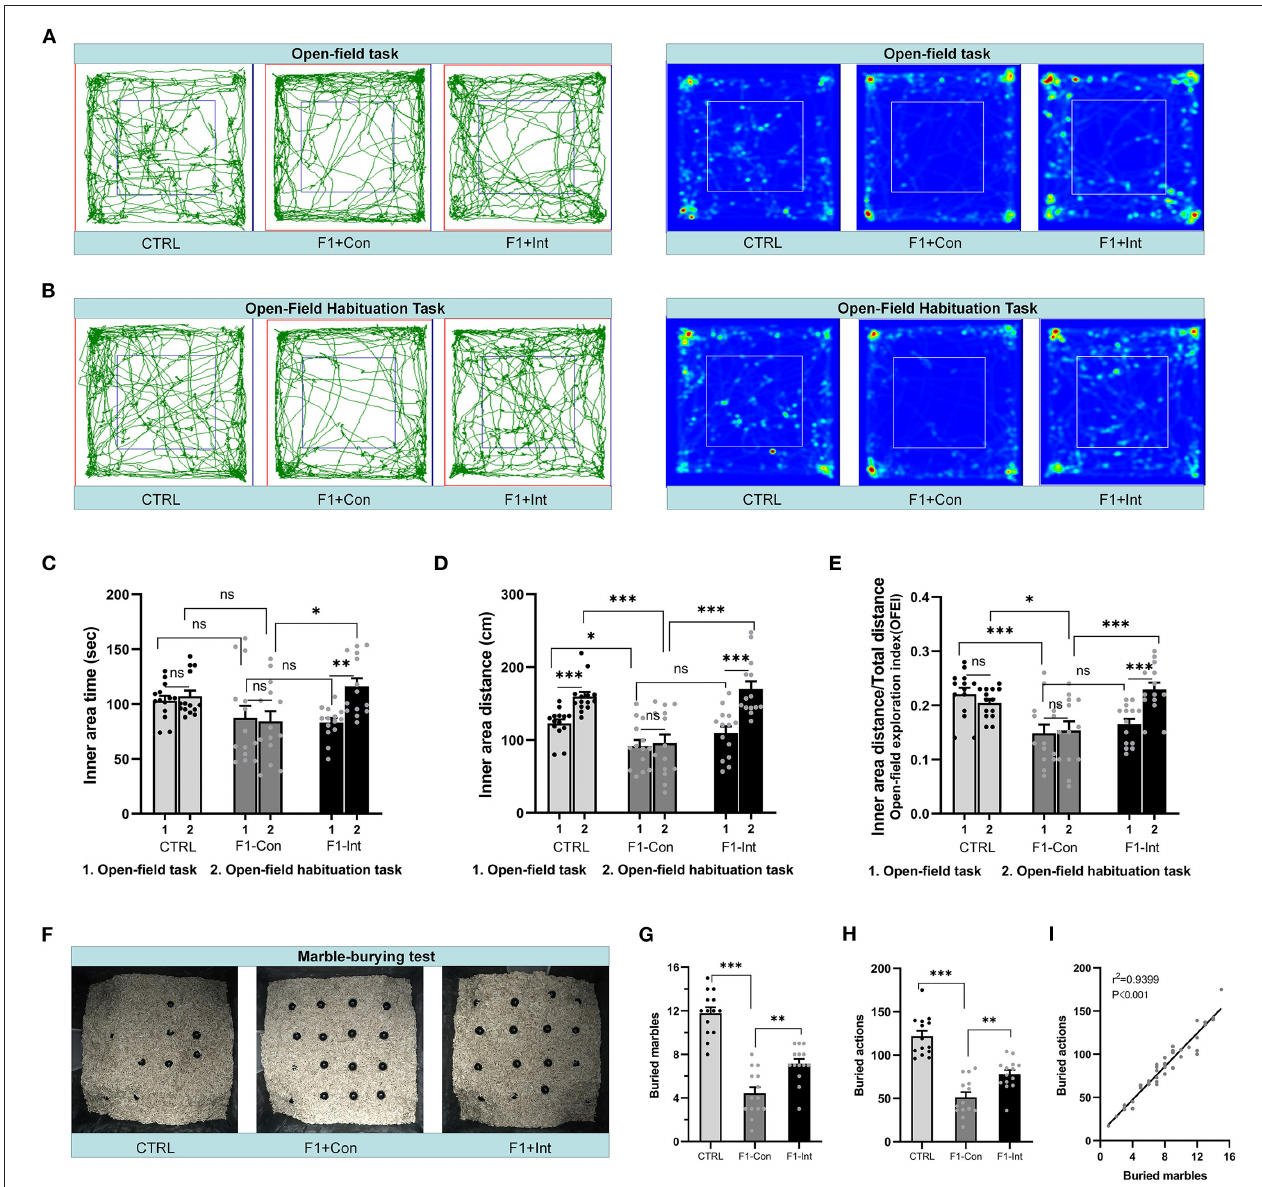
FIGURE 3 | Baclofen treatment corrected the locomotor, exploratory activity and marble-burying deficits in F1 mice. (A,B) Representative traces and heatmaps of mice in the open-field task (task 1) and open-field habituation task (task 2). (C) Time traveled in the inner zone by mice in the two open-field tasks. (D) Distance traveled by mice in the inner zone in the two open-field tests. (E) The open-field exploration index (OFEI = distance traveled in the inner zone/the total distance traveled) of mice in the two open-field tasks. In ( C–E) , Student’s paired t -test was used to compare the differences in behavior in the two tasks between each group of mice, and one-way ANOVA followed by the Bonferroni post-hoc test was used to compare the difference in the same task across the four groups; * p < 0.05, ** p < 0.01 *** p < 0.001. All data for all figures are plotted as the mean ± SEM. Each group had 14 mice ( n = 14). (F) Representative marble-burying maps after the marble-burying test. (G) The numbers of buried marbles for each group of mice. (H) The number of burying actions for each group of mice. In (G,H) , one-way ANOVA followed by the Bonferroni post-hoc test was used to compare the differences among groups; ** p < 0.01, *** p < 0.001. All data for all figures are plotted as the mean ± SEM. Each group had 14 mice ( n = 14). (I) Pearson correlation and linear regression analysis between the number of buried marbles and the number of burying actions. All mice were included ( n = 42) in the analysis, and there was a linear correlation between the number of buried marbles and the number of burying actions.